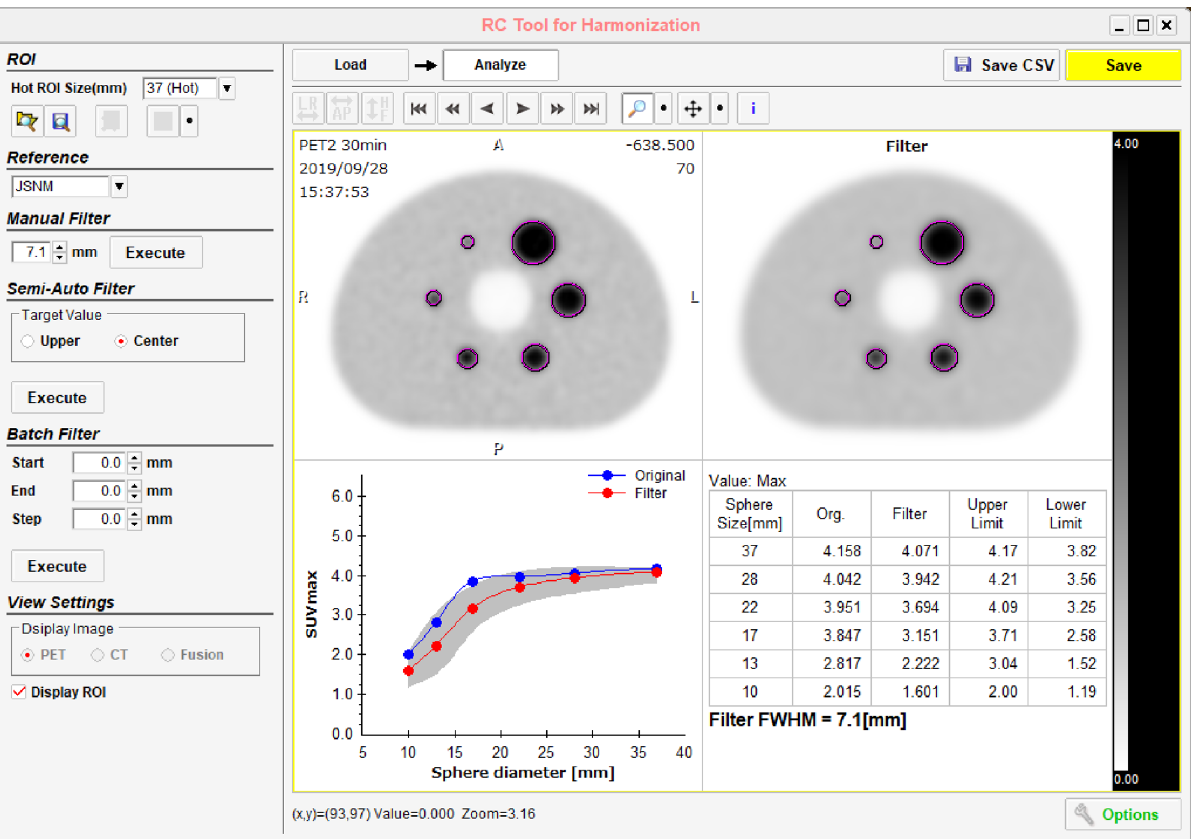
Figure 1. RMSE-based additional filter optimization using the RC Tool for Harmonization.